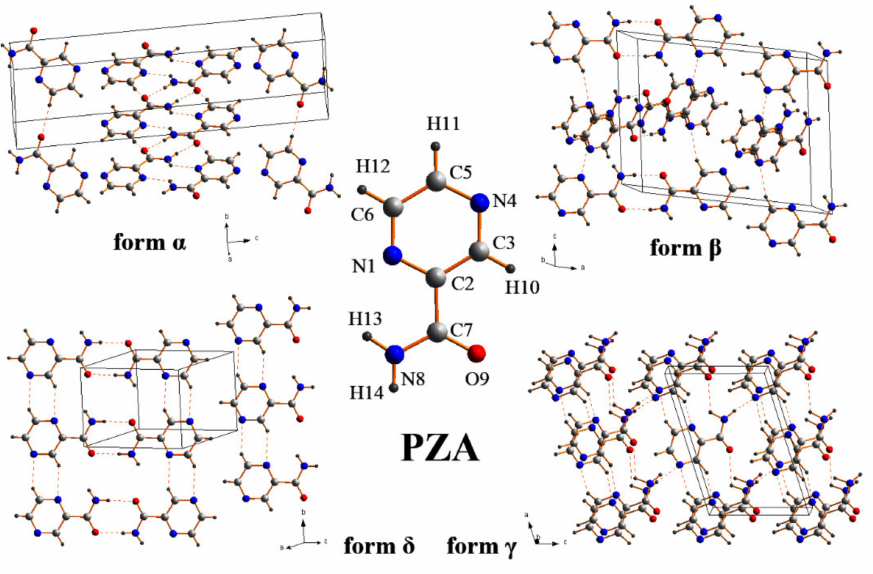
Figure 2. Crystal structures of PZA polymorphic forms: α , β , δ , and γ forms. Reprinted with permission from Ref. [65]. Copyright 2012 American Chemical